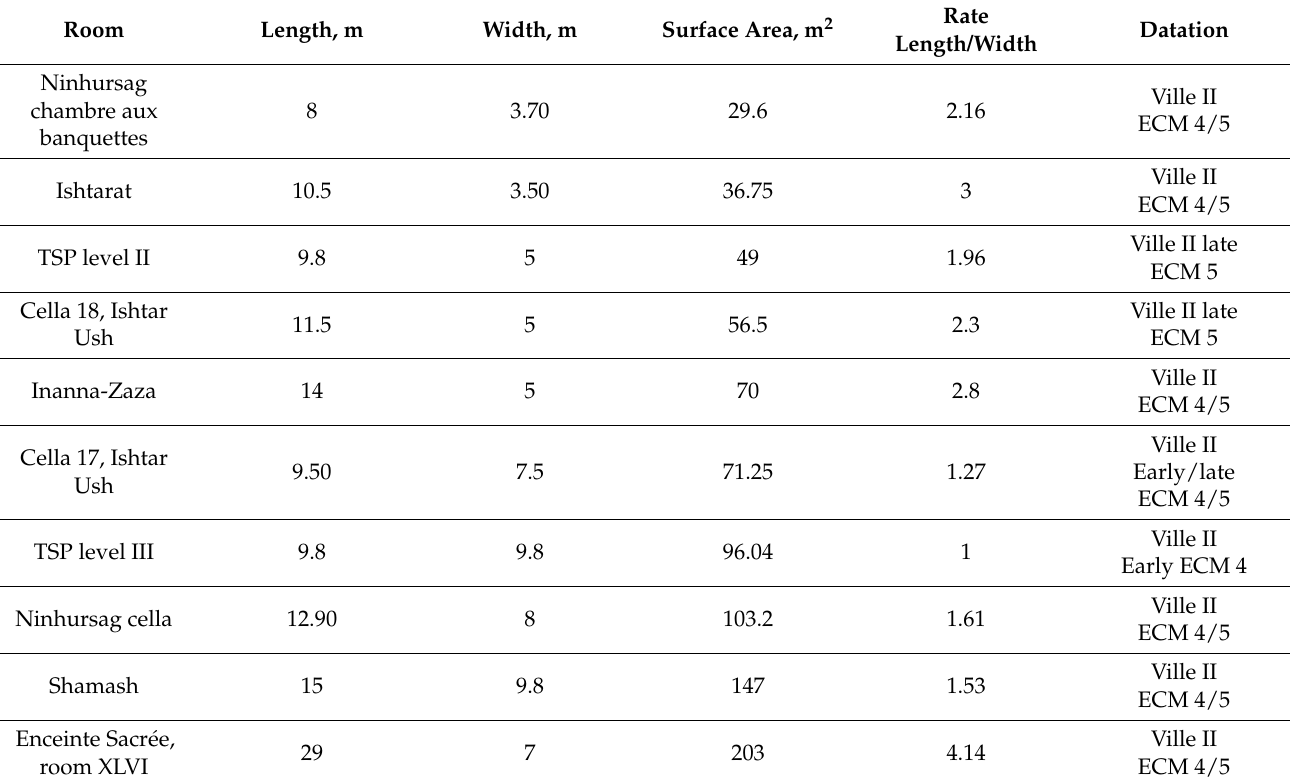
Table 1. Mari, ceremonial rooms’ length and width, ordered by surface